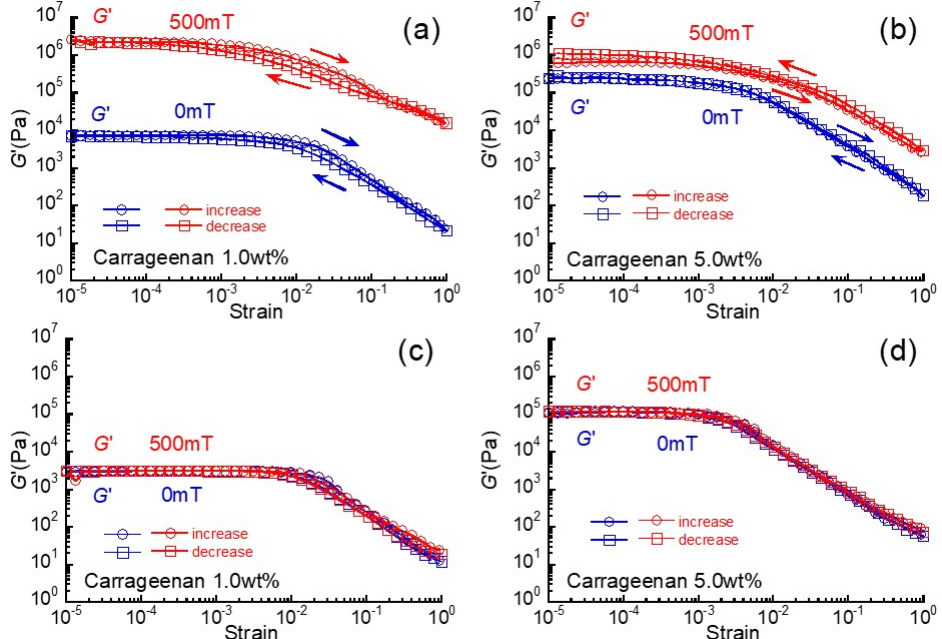
Figure 6. Hysteresis in the strain dependence of storage modulus for ( a , b ) magnetic hydrogels (CI: 70 wt%) and ( c , d ) carrageenan hydrogels without magnetic particles. ( a , c ) 1 wt% carrageenan, ( b , d ) 5 wt%